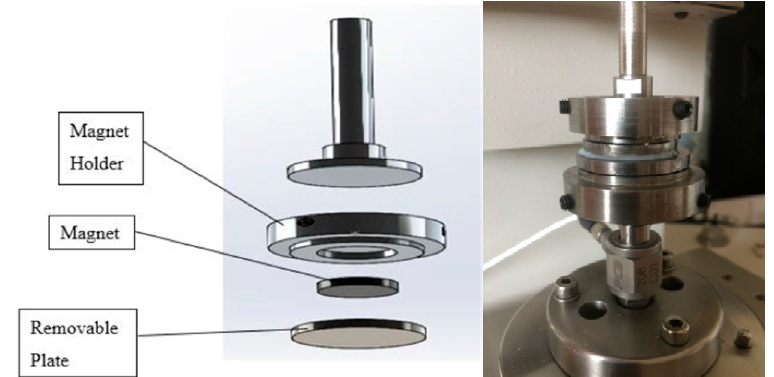
Figure 8. Design of top plate (left) and entire test assembly (right).